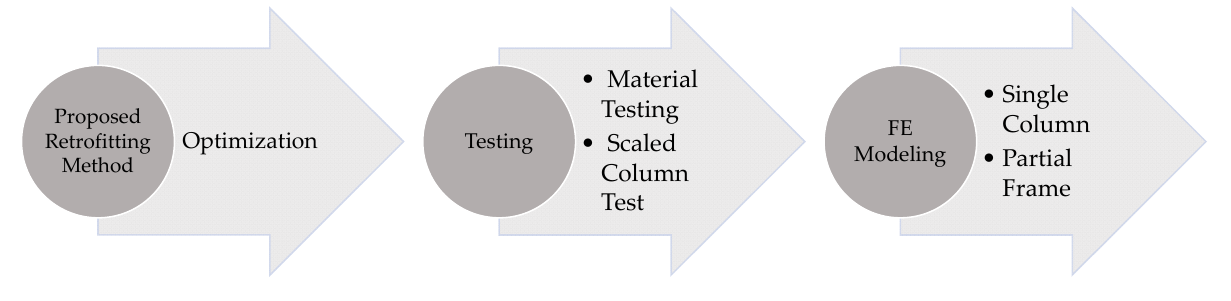
Figure 2. Flowchart of the study.